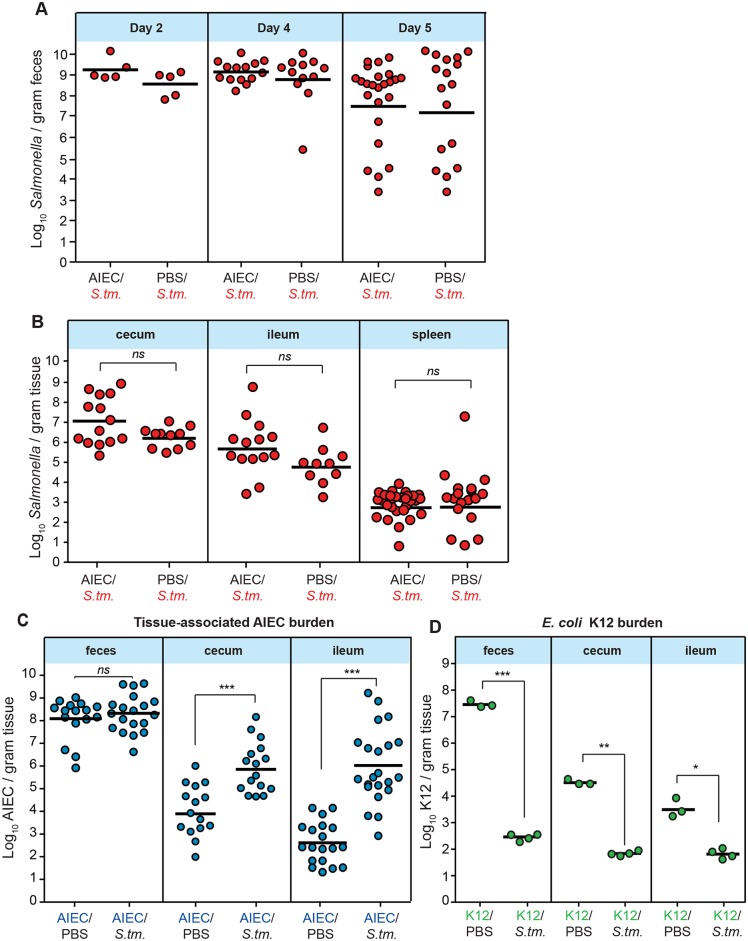
Tissue-associated expansion of AIEC following Salmonella gastroenteritis.(A) Fecal Salmonella loads on day 2, 4, and 5 after infection. Each data point is from one animal and represents 3–4 independent experiments. (B) Tissue-associated Salmonella burdens in the cecum, ileum, and spleen on day 5 after Salmonella infection. Each point is from one animal and data represents 3–4 independent experiments. (C) Tissue-associated AIEC burden in feces, cecum and ileum on day 5 after Salmonella infection. Each point is from one animal and data represent 3–4 independent experiments. (D) Tissue-associated E. coli K12 in feces, cecum and ileum on day 5 after Salmonella infection. Each point is from one animal. ns not significantly different between comparison groups, *p<0.05, **p<0.01, ***p< 0.001 (Mann-Whitney test).